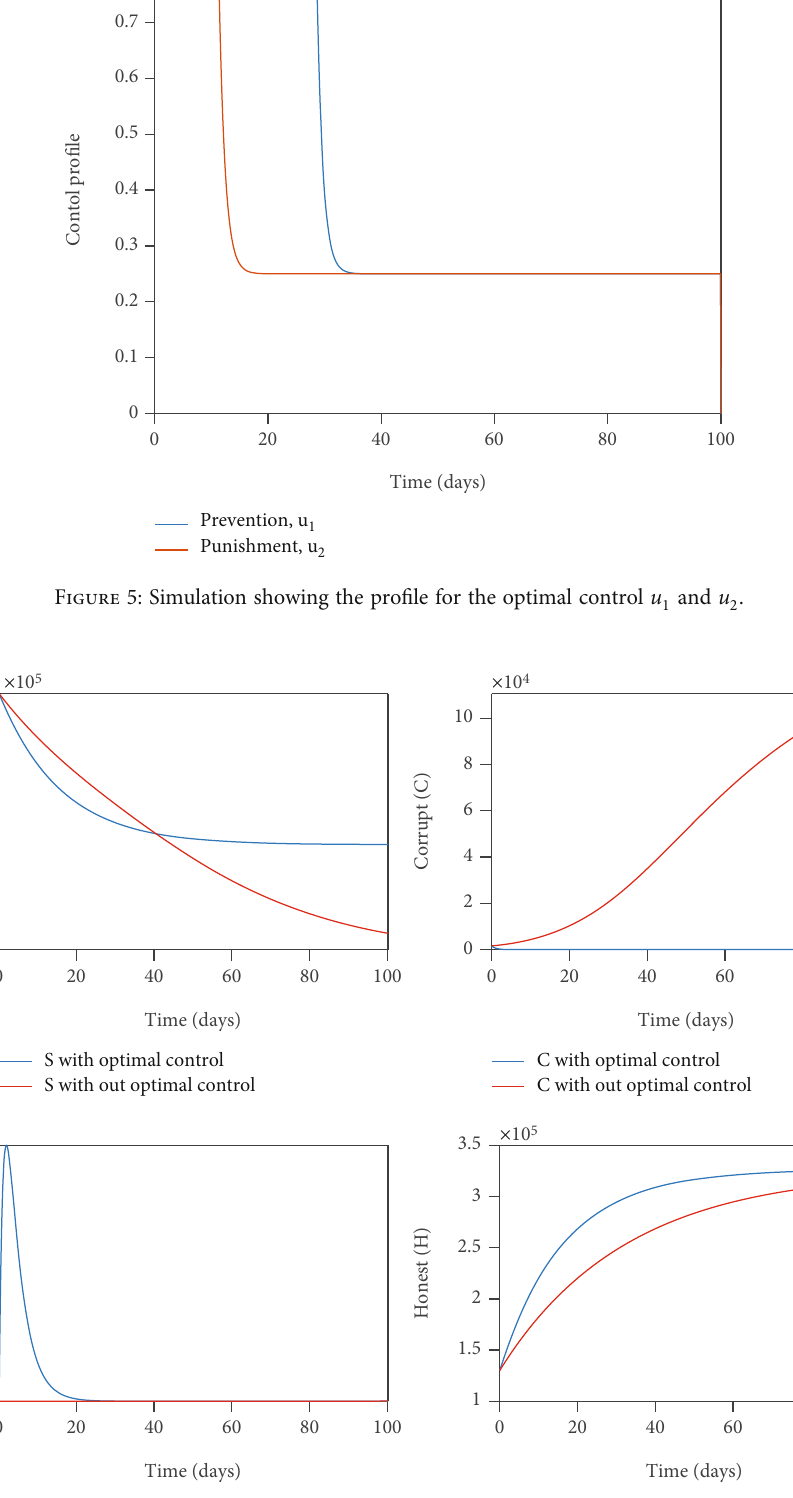
Figure 6: Simulation showing the optimal solution for susceptible, corrupt, jailed, and honest via use of u 0 : 000001 , and α = 0 : 014